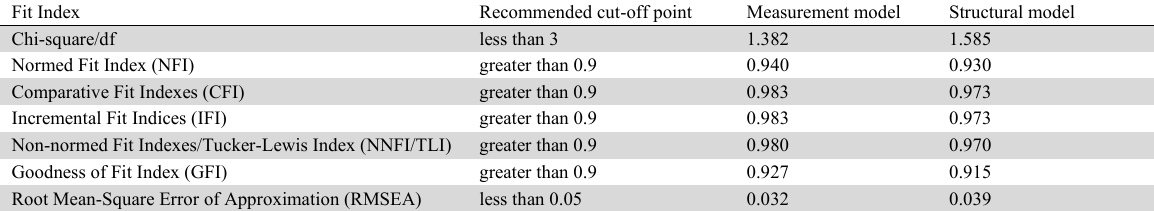
Indices of model fit in the Measurement Model and Structural Model